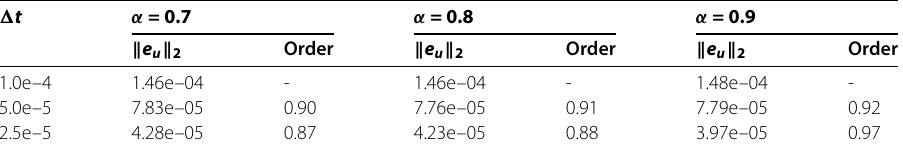
Table 1 Error and order of convergence of time discretization for example 1 ( h = 0.3,